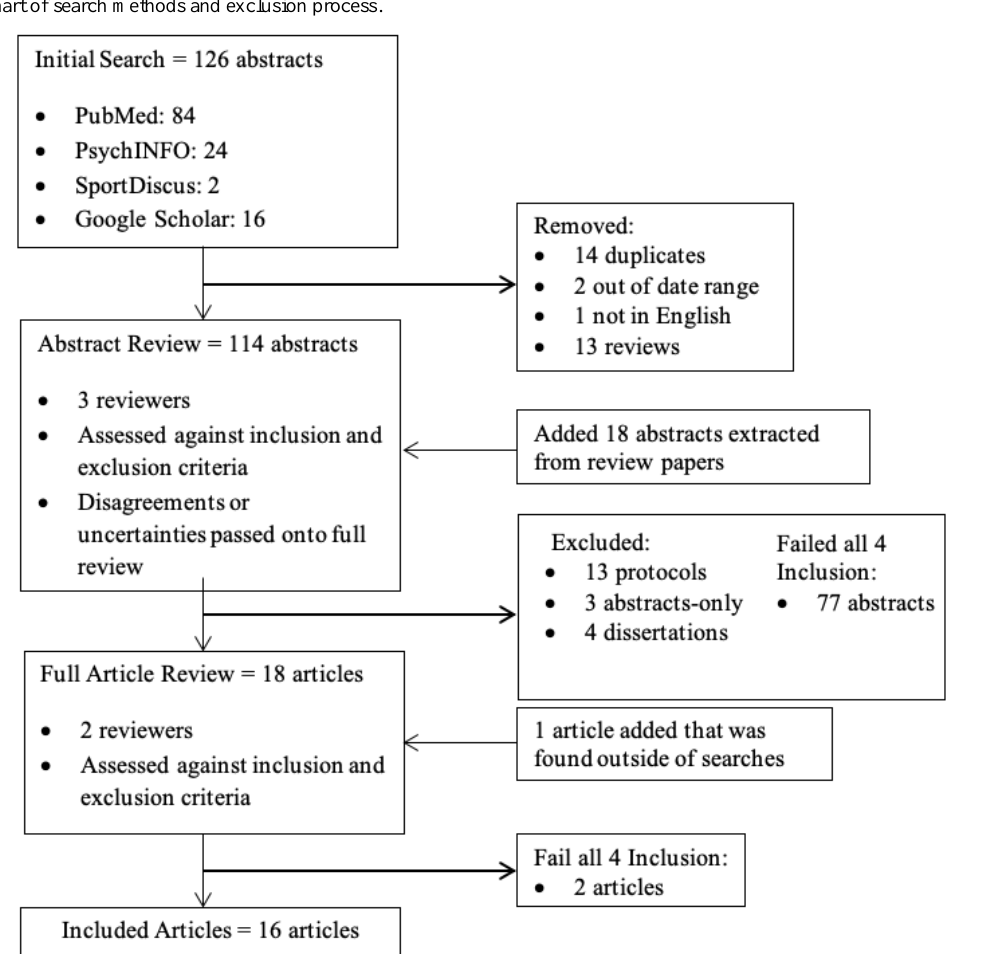
Figure 1. Flowchart of search methods and exclusion